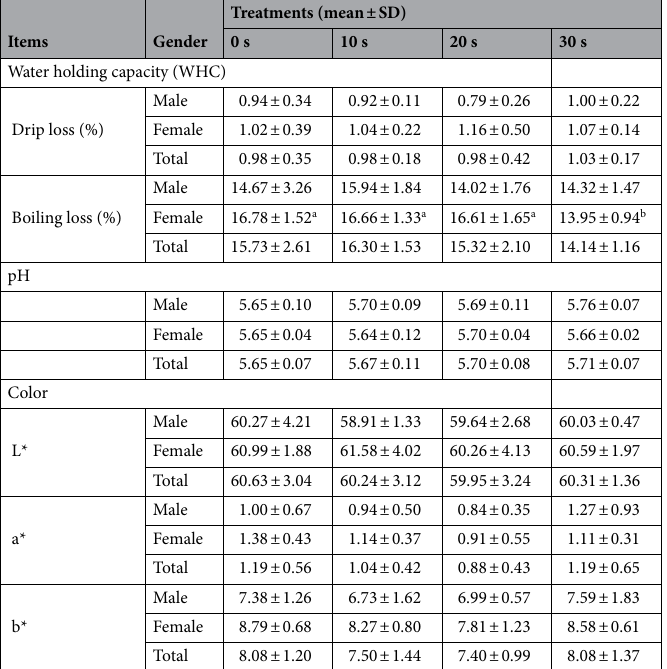
Table 6. Meat quality of breast muscle in crossbred Pradu Hang Dam Chicken obtained from 4 treatment groups. a,b Values with different superscript letters in a row are significantly different (p-value < 0.05).